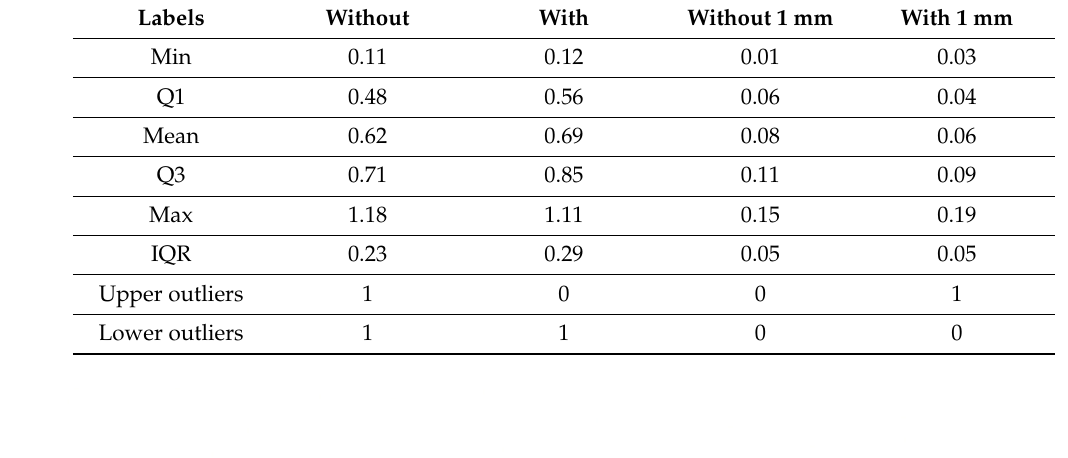
Table 1. Descriptive statistics for data. “without” means weight after drying without clear aligner; “with” means weight after drying with clear aligner; “without 1 mm” means weight after sieving at 1 mm without clear aligner; “with 1 mm” means weight after sieving at 1 mm with clear aligner. Labels Without With Without 1 mm With 1 mm Min 0.11 0.12